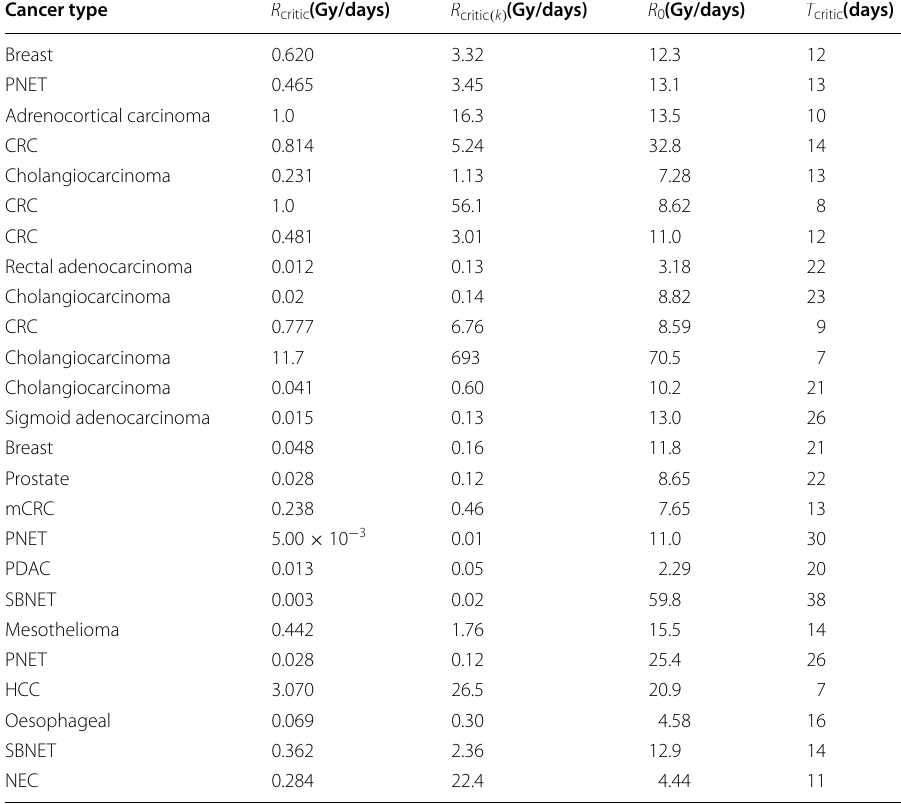
R critic , critical dose rate; R critic ( k ) , critical dose rate considering the T k ; R 0 , initial dose rate; T critic , critical